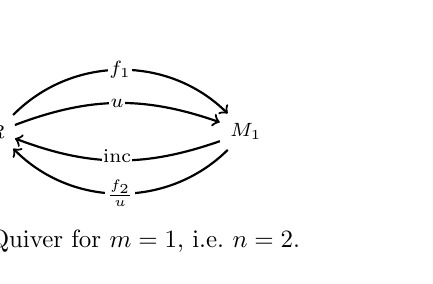
Figure 2. The quivers presenting the NCCR A = End R T (3.10). One may also have to add loops at vertices according to the rules in the main text. Since Hom R ( M j ; M j ) (cid:24) = R for j = 0 ; : : : ; m (with M 0 (cid:17) R ), we must see the generators of R at every vertex. Indeed v ( u ) is the complete (anti)clockwise loop based at M j ; z; t can be seen by following the above